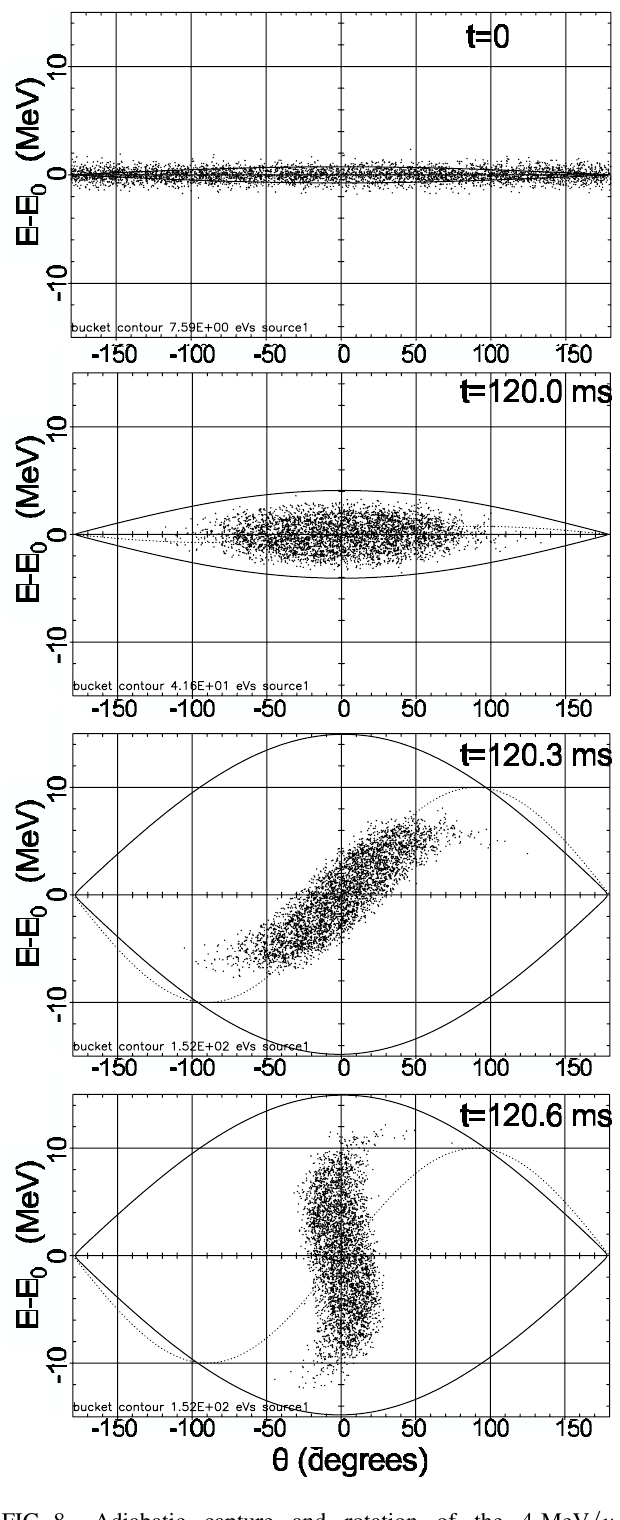
FIG. 8. Adiabatic capture and rotation of the 4 MeV =u 238 U 92 (cid:7) bunch by applying sinusoidal rf signals (dotted lines) to the BB cavity. The dots represent the particle distribution in the longitudinal phase space. The rotation is made with a 2 kV peak voltage and results in a bunch length ( 4 (cid:4) ) of 30 m ( 48 (cid:3) ). No electron cooling is included in the ESME